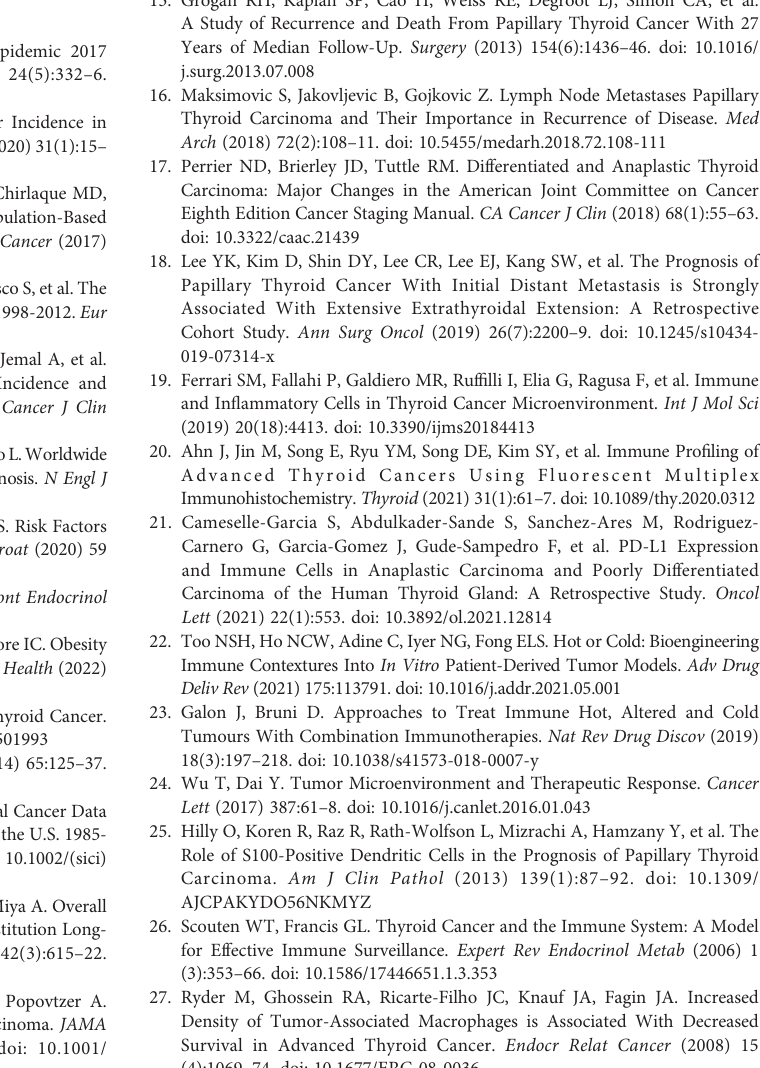
Supplementary Figure 1 | Representative hematoxylin and eosin staining images of both collected TC and para-cancerous thyroid tissues. (A) Representative hematoxylin and eosin staining image of para-cancerous thyroid tissues. (B) Representative hematoxylin and eosin staining image of PTC tissues. Magni fi cation